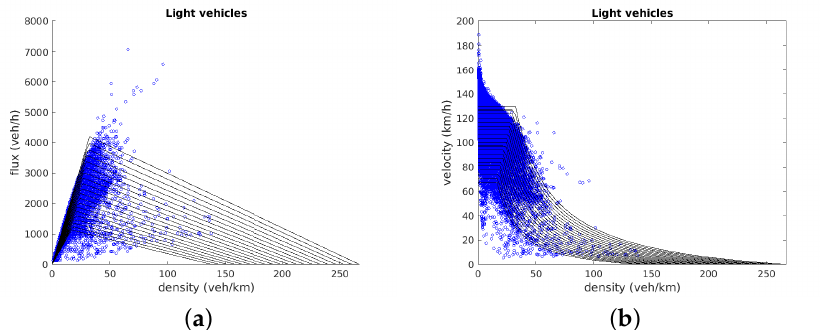
Figure 9. ( a ) Flux–density and ( b ) velocity–density relationships for cars with real data superimposed.